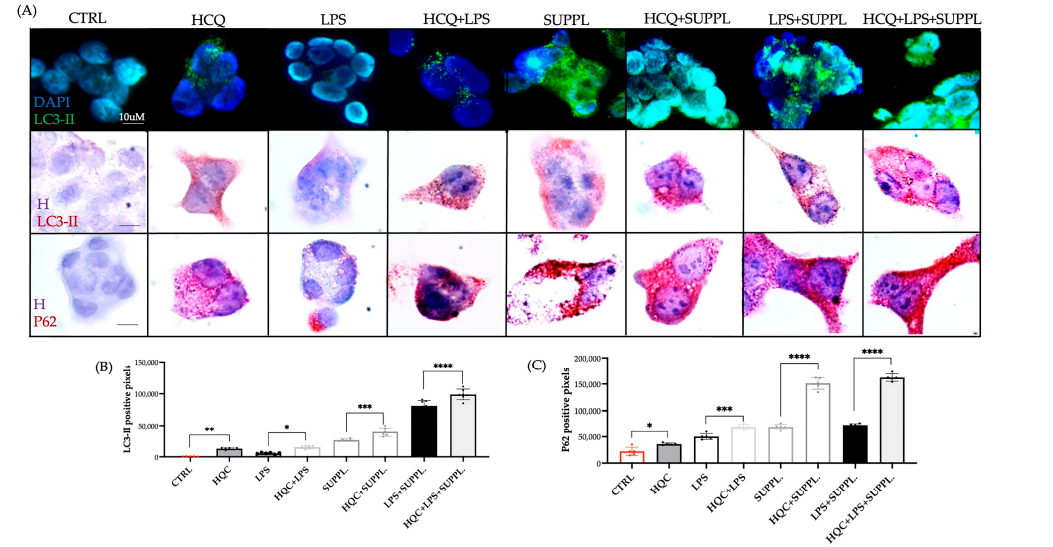
Figure 4. ( A ) The effect of the supplement (SUPPL, 1.2 µ M SPD + 92 µ M EUG) alone or in combination with ng/mL lipopolysaccharide (LPS) for 2 h on fluorescent green (FG)-stained LC3-II puncta, chromogen red-stained LC3-II and chromogen red-stained P62 in comparison to the untreated control and LPS alone (magnification × 60). All treatments were performed in the presence and absence of 20 µ M hydroxychloroquine (HCQ). ( B ) Quantification of the LC3-II steady state and turnover levels. ( C ) Quantification of the P62 steady state and turnover levels. Significant differences were represented as follows: * 0.01 < p < 0.05, ** 0.001 < p < 0.01, *** 0.0001 < p < 0.001, **** p < 0.0001. The black dots indicate the positioning of the individual replicates within the bar for each sample. DAPI = nuclear staining in FG imaging: H = hematoxylin.